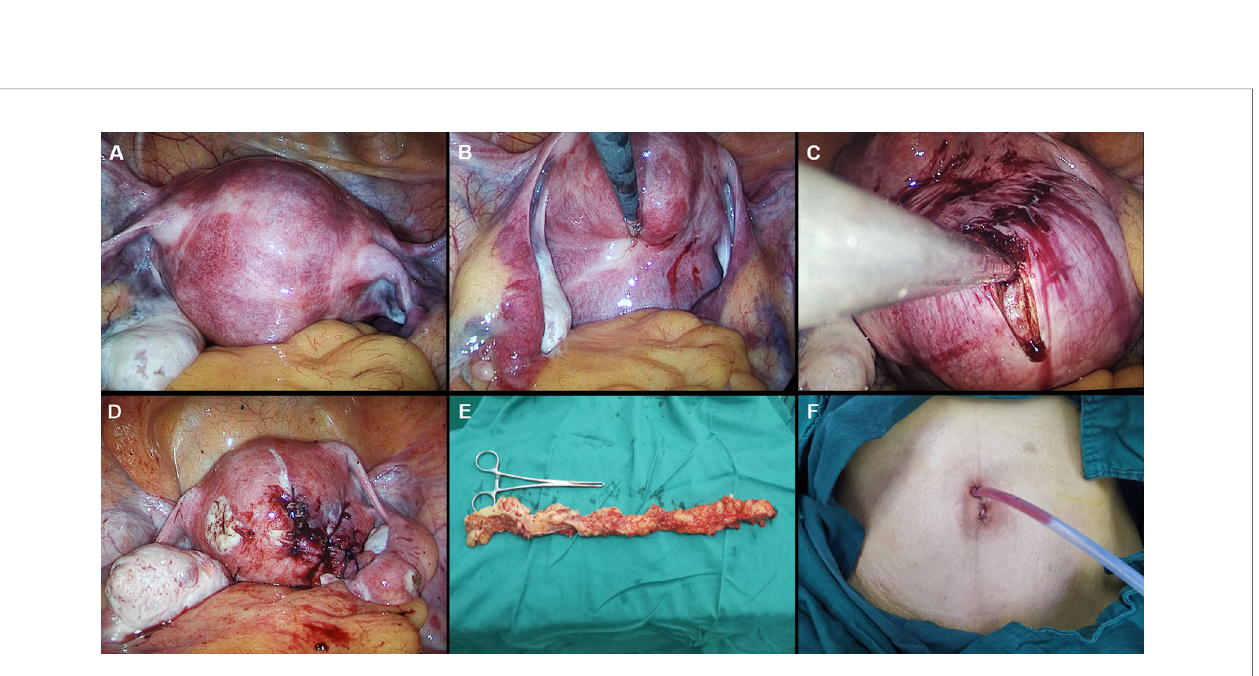
FIGURE 2 | (A – F) The operation